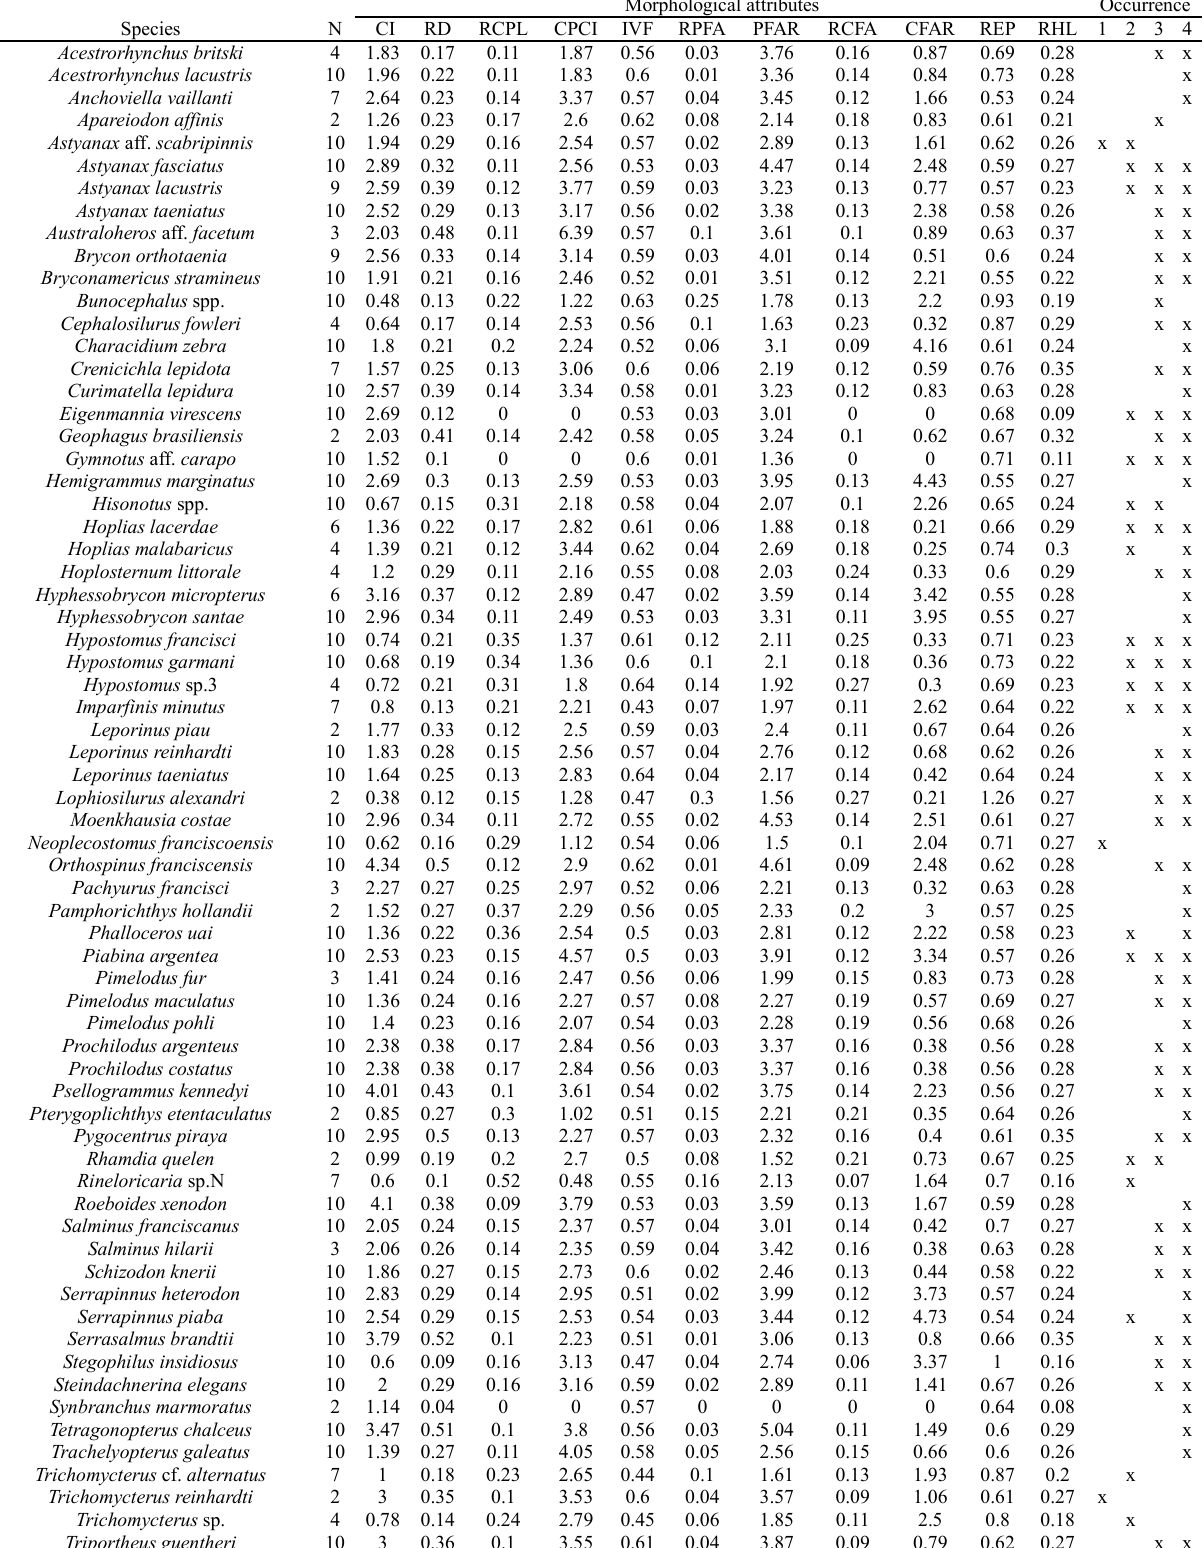
Table 1. Means values of 11 morphological attributes estimated for 67 fish species (abbreviations of morphological attributes are in the Material and Methods section) and species distribution along the rio das Velhas basin (1 = headwaters of the rio das Velhas; 2 = upper course of the rio dasVelhas; 3 = middle course of the rio das Velhas; 4 = lower course of the rio das Velhas). Morphological Species N